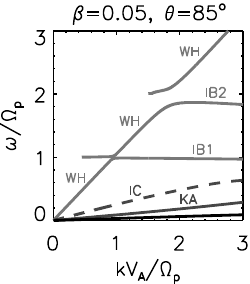
Figure 1. Dispersion relations calculated for a propagation angle of 85 ◦ for low-beta plasma ( β = 0 . 05), showing whistler modes (WH), ion Bernstein fundamental mode (IB1) and harmonics (IB2), kinetic Alfvén mode (KA), and kinetic slow mode (KS) under the condition of the damping rate magnitude less than the wave frequency. Dashed line shows ion cyclotron mode (IC) for a propagation angle of 75 ◦